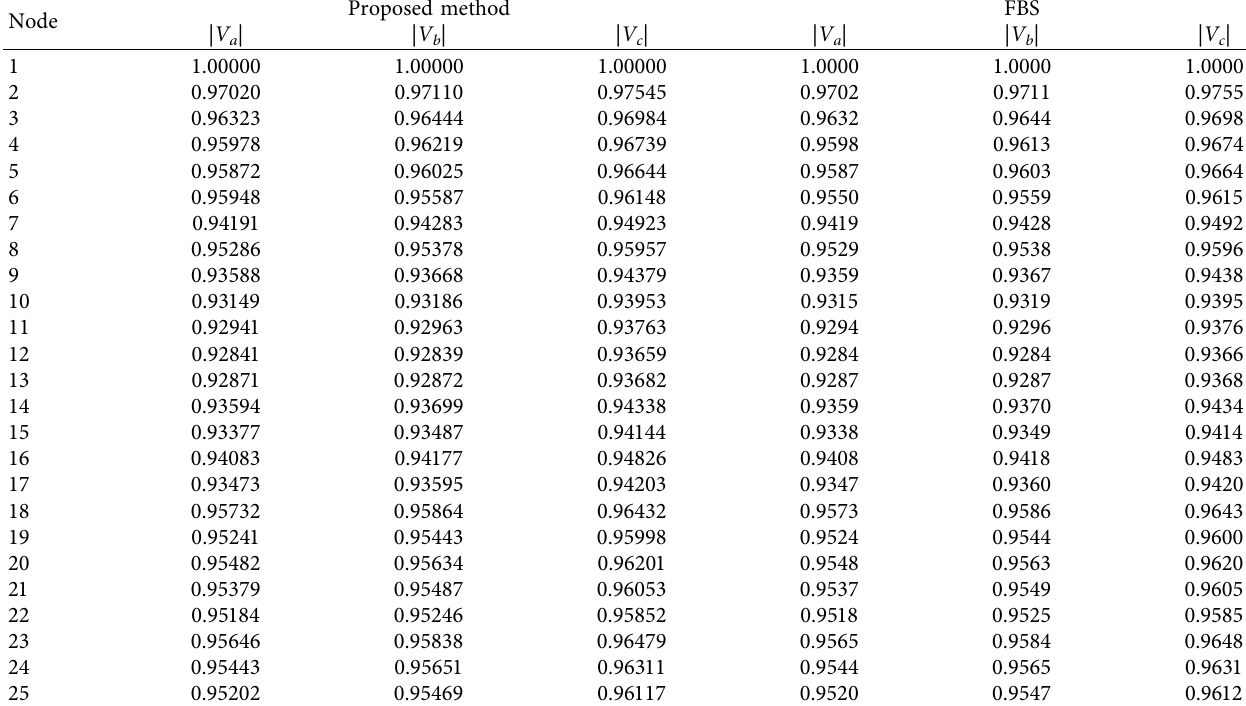
Table 11: Voltage profile of 25-bus network.